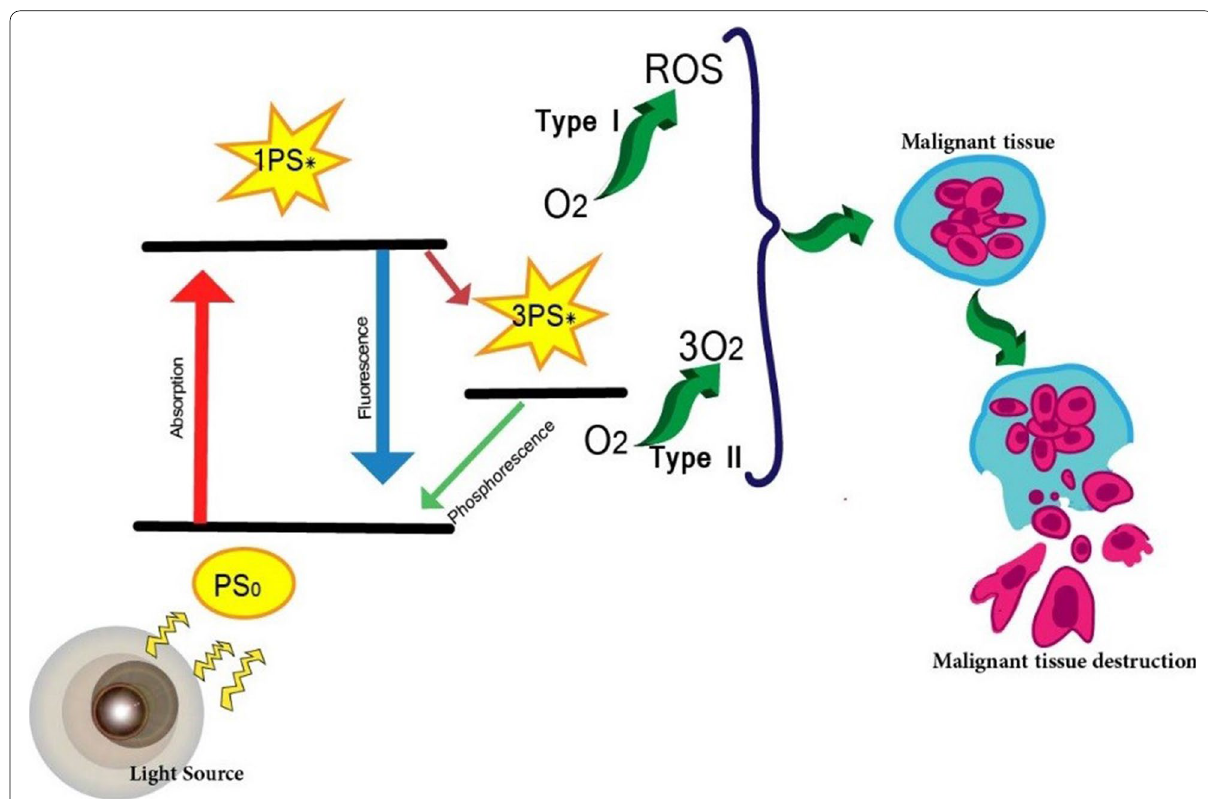
Fig. 1 Reaction types I and type II of photosensitizer application in destroying the malignant tissues with the involvement of oxygen species (ROS) in photodynamic therapy